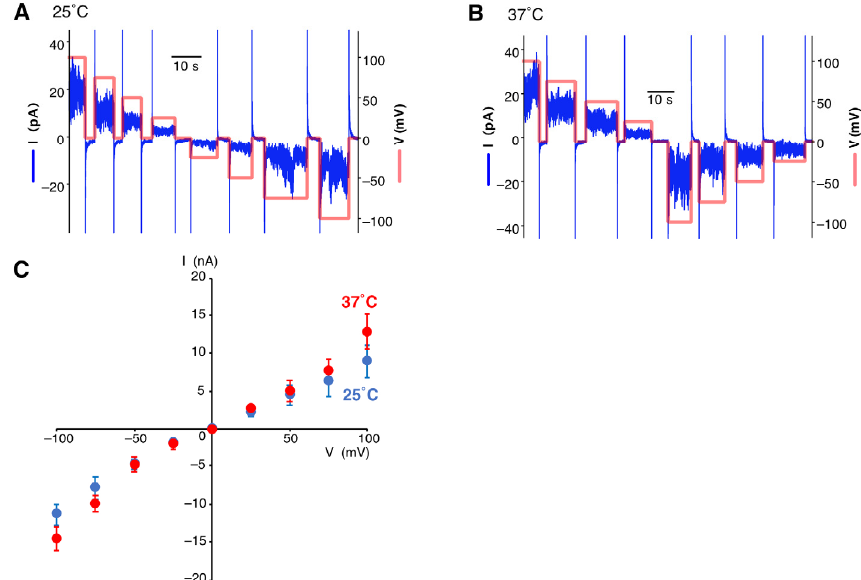
Figure 2. Single-channel current recording of cell-free synthesized KCNK2 channel at 25 °C ( A ) or at 37 °C ( B ). The blue line and main axis indicate current signal, and the red line and secondary axis show voltage. Bars indicate time scale. ( C ) I-V plots. The current record data at 25 °C (blue) and 37 °C (red) were analyzed by Clampfit 10.4 software. Results are shown as the mean ± S.E. ( n = 6).